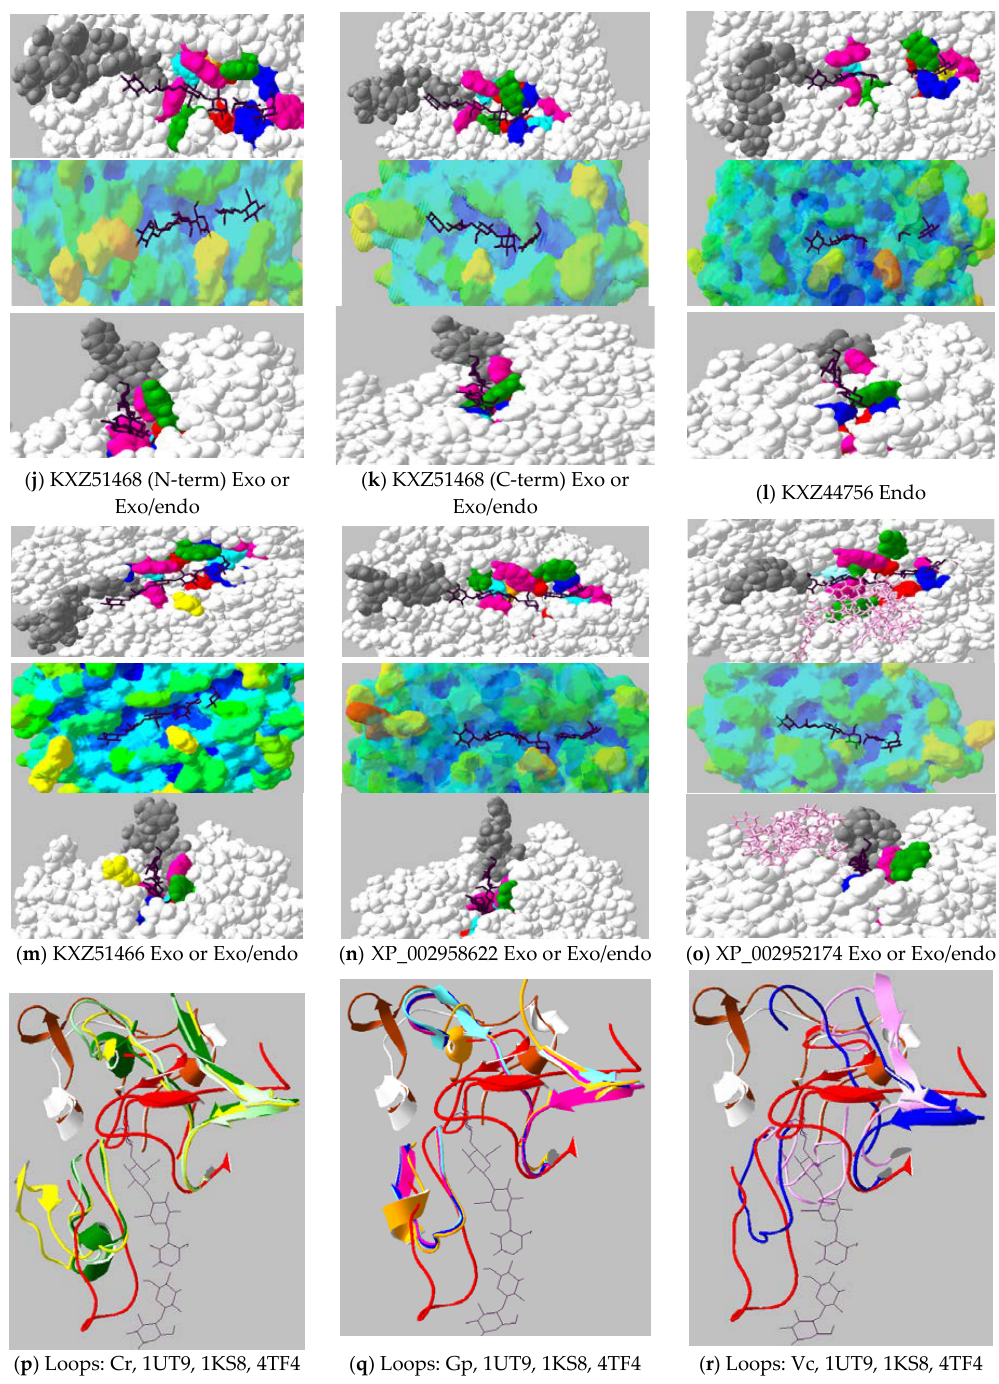
Figure 6. Active-site architecture of selected family GH9 cellulases determined from X-ray structures and homology models. Upper panels ( a – o ): Top view of the active-site. Critical residues surrounding the active-site. Blue, H; pink, W; turquoise, R/K; yellow, S; in lieu of substrate-binding, W; green, Y; orange, F; red, catalytic residues (E/D); grey, blocking residues/loops; Middle panels ( a – o ): Cavity analysis of the active-site pocket highlighting clefts, tunnels, and blocks in various shades. Dark blue, completely buried; orange/red, at least 75% surface accessible. Upper and middle panels showing substrate (C4 + C2) from − 4 non-reducing (left) to +2 reducing end (right); Lower panels ( a – o ): View of the active-site from +2 to − 4 subsite looking down the cleft/barrel highlighting the absence or presence of “tower blocks” (grey) at the non-reducing end. The extra loop in Vc2952174 ( o ) is shown as ball and stick (pink); ( p – r ): Analysis of the blocking loops/secondary structure elements in microalgal CDs compared with 1KS8, (endo-type, white), 4TF4 (exo/endo-type, brown) and 1UT9 (exo-type,